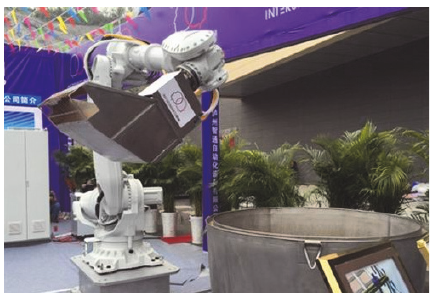
Figure 2: Robot method for